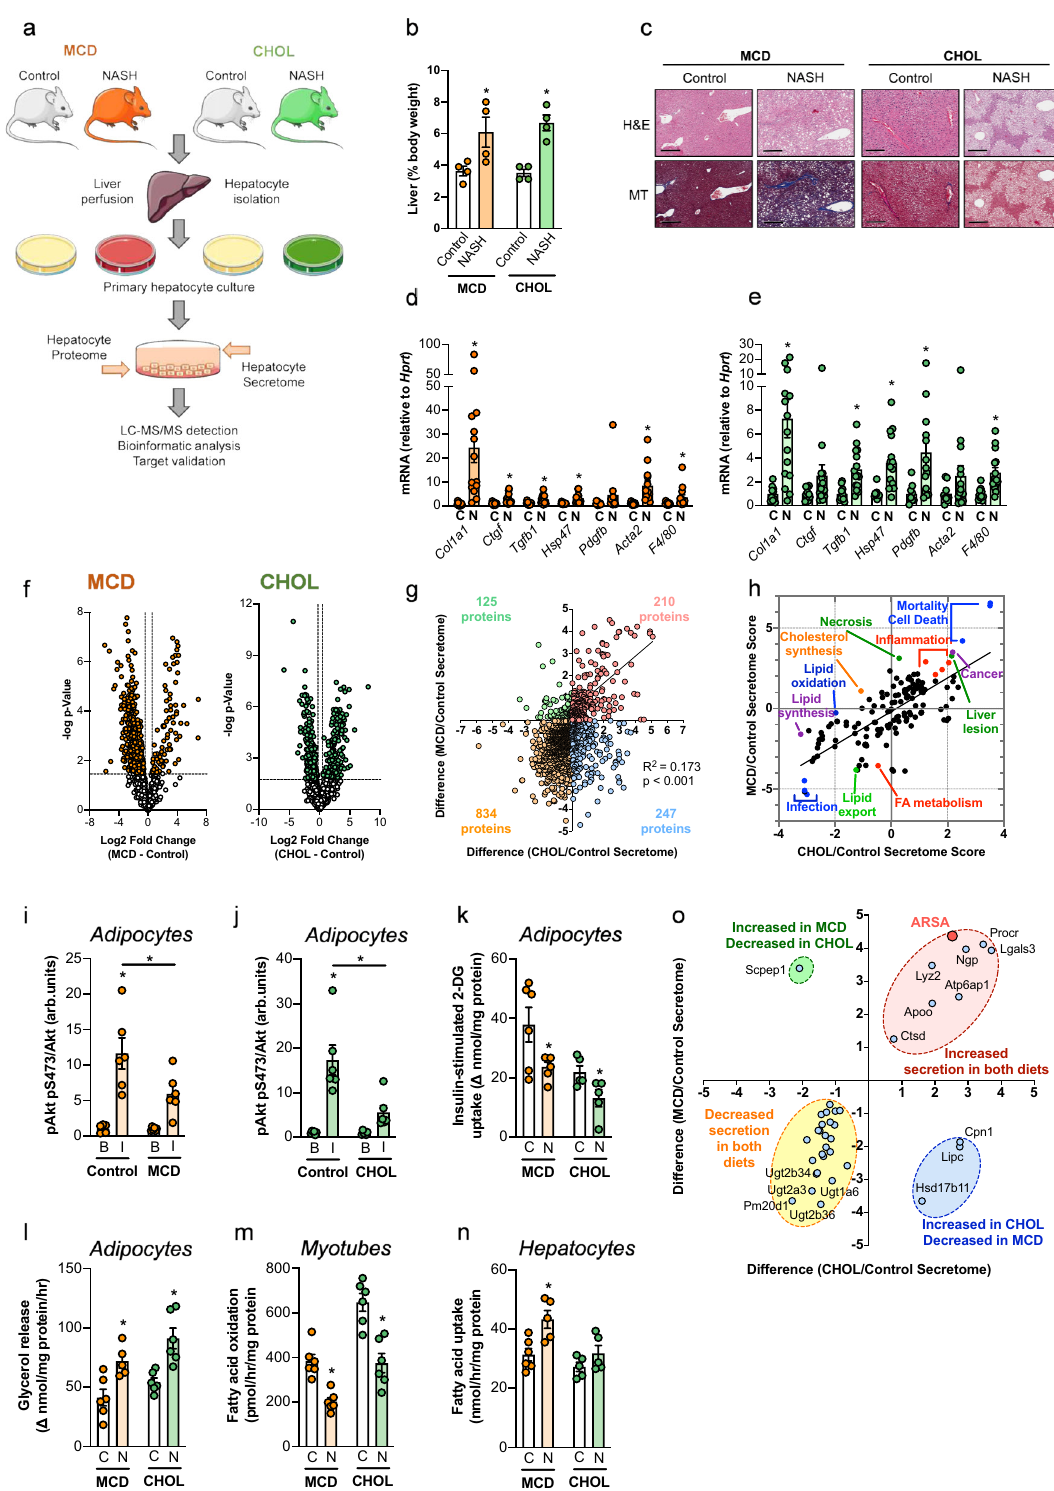
myotubes and primary murine hepatocytes. NASH-secreted fac- tors from both dietary regimes reduced insulin-stimulated phosphorylation of protein kinase Akt, the insulin receptor (IR) and/or insulin receptor substrate 1 (IRS1) in all cell types (Fig. 1i, j and Supplementary Fig. S1O – Q). Functional analysis in adipo- cytes showed that the NASH hepatocyte medium induced a ~40% decrease in insulin-stimulated 2-deoxyglucose uptake (Fig. 1k). NATURE COMMUNICATIONS| (2022) 13:1259